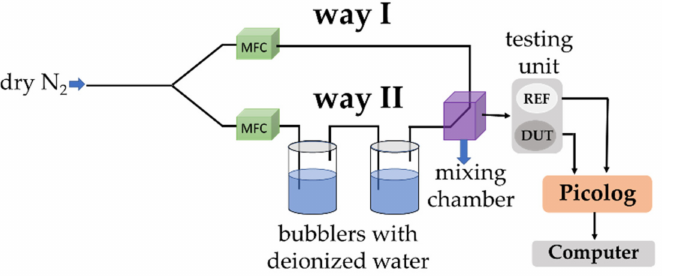
Figure 3. Experimental setup employed for RH measurements. Abbreviations: M.F.C., mass flow controller; DUT, device under testing; and REF, reference